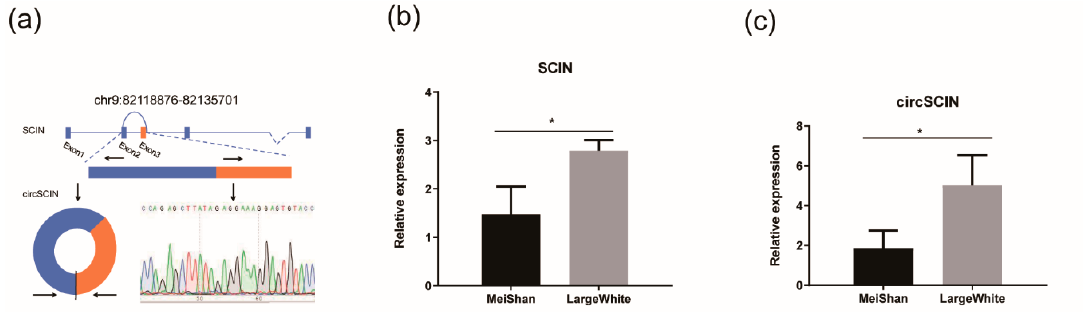
Figure 3. RT-qPCR analysis of the expression levels of circSCIN and its parent gene SCIN . ( a ) The genomic location of circSCIN and Sanger sequencing of a PCR product resulting from divergent primers for demonstrating the backsplicing of two exons in SCIN . ( b ) The expression of circSCIN was significantly increased in Large White pigs. ( c ) The abundance of SCIN was significantly increased in Large White pigs. Data in (b) and (c) were the means ± s.e.m. * p ≤ 0.05 (Student's t-test).